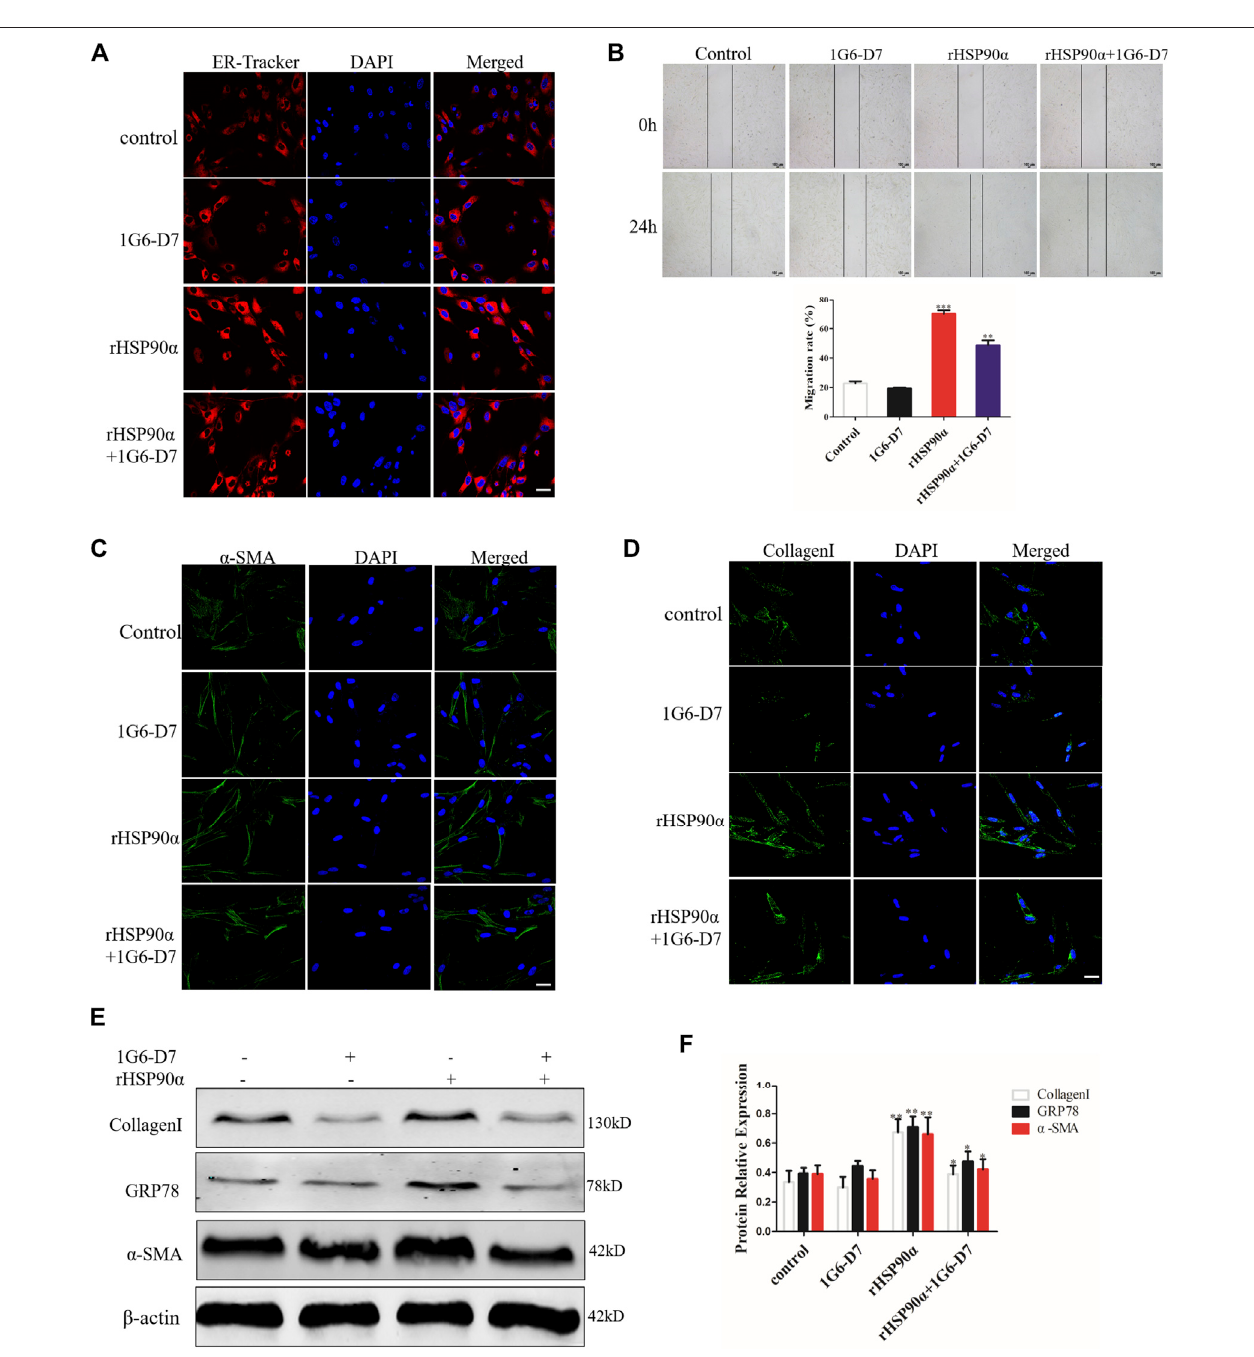
FIGURE6| Monoclonalantibody1G6-D7inhibitsERstressinducedbyeHSP90 α invitro .(A) .RepresentativeimagesshowingER-TrackerstainingofIMR90cells pre-treatedwithorwithout1G6-D7(10 μ g/ml)andfollowedbyrHSP90 α for24 h,scalebar (cid:1) 50 μ m. (B) CellmigrationwasexaminedinIMR90cellsbyawoundhealing assay. (C,D) . Representative images showing immuno fl uorescence staining of α -SMA and CollagenI in IMR90 cells. (E,F) . Western blot analysis of the expression of CollagenI, GRP78 and α -SMA. β -actin was used as an internal control. * p < 0.05, ** p < 0.01.